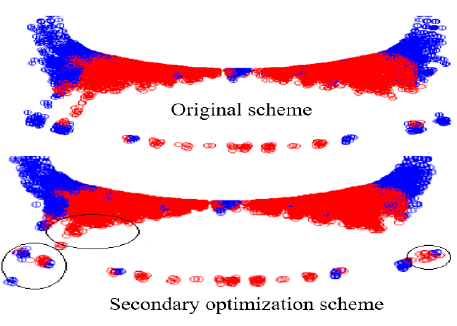
Figure 18. Plastic zone.